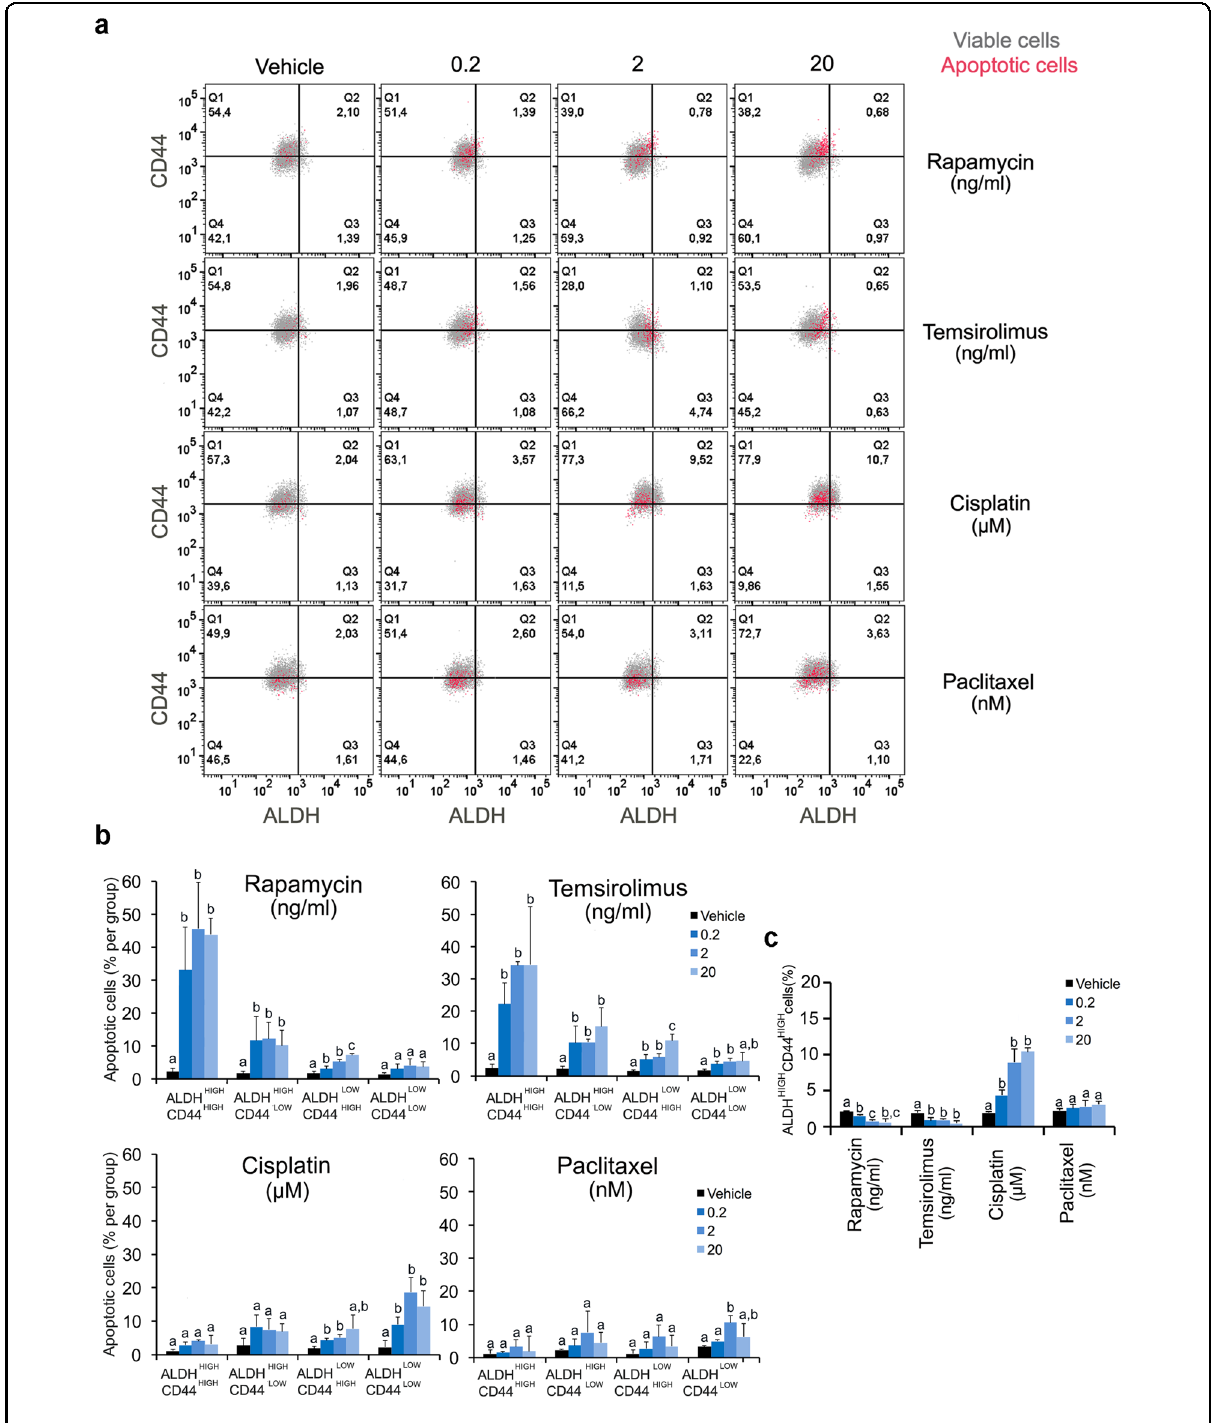
Fig. 3 (See legend on next